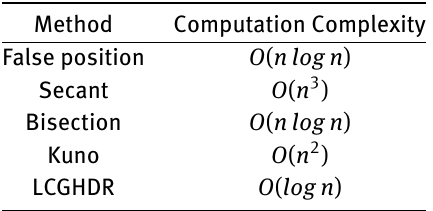
Table 8: Computation complexity of different